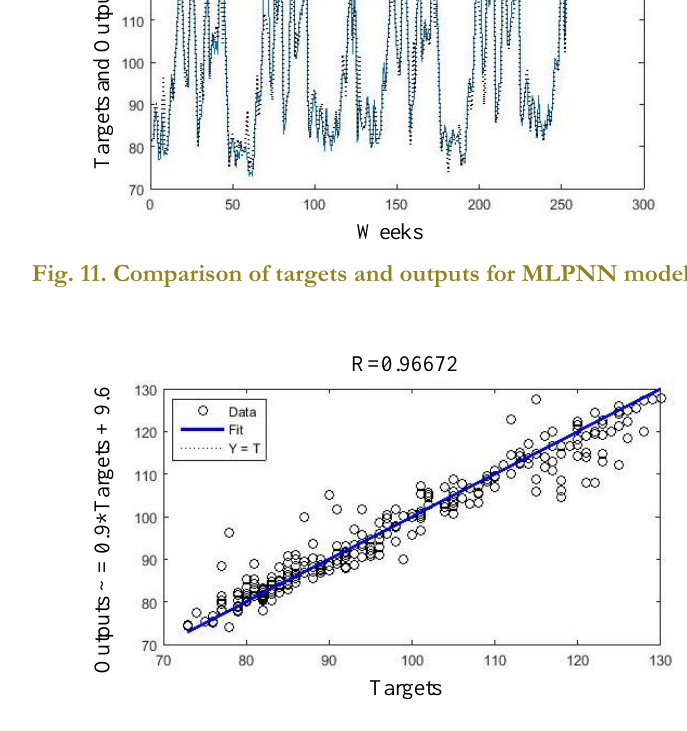
Fig. 12. Correlation between the targets and outputs for MLPNN